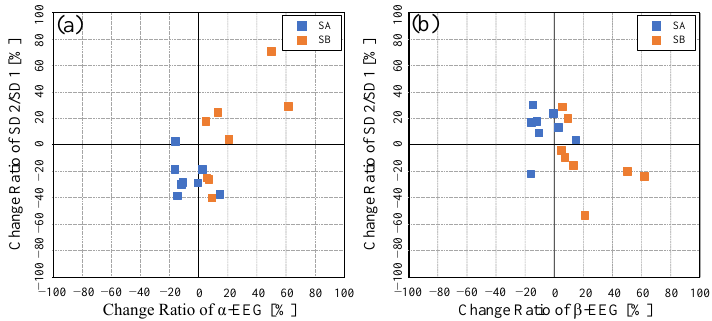
Figure 9. Relationship between ( a ) α-EEG and SD2/SD1 and ( b ) β-EEG and SD2/SD1, respectively.